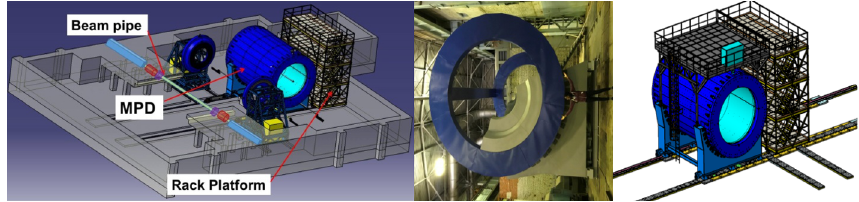
Figure 2. On the left: Room for the MPD detector. In the center: The real size model of the MPD. On the right: the MPD detector and the Platform for the MPD electronic racks [2],